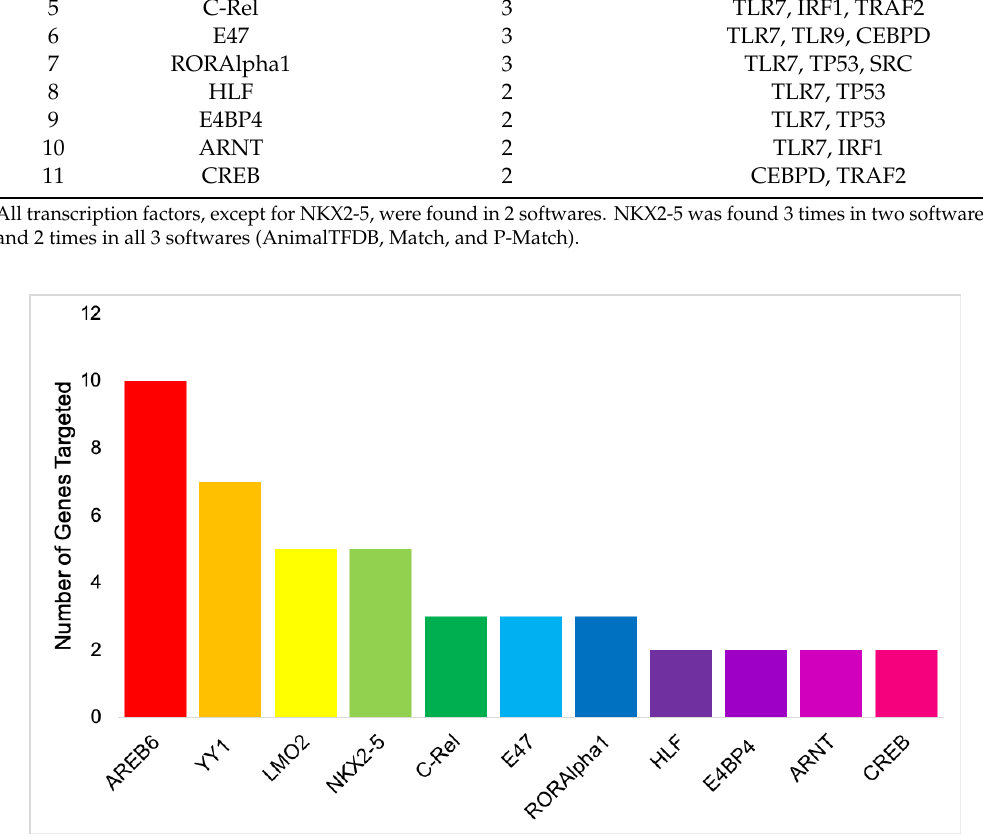
Figure 1. Bar chart illustrating the number of genes identified as targets for each transcription factor.